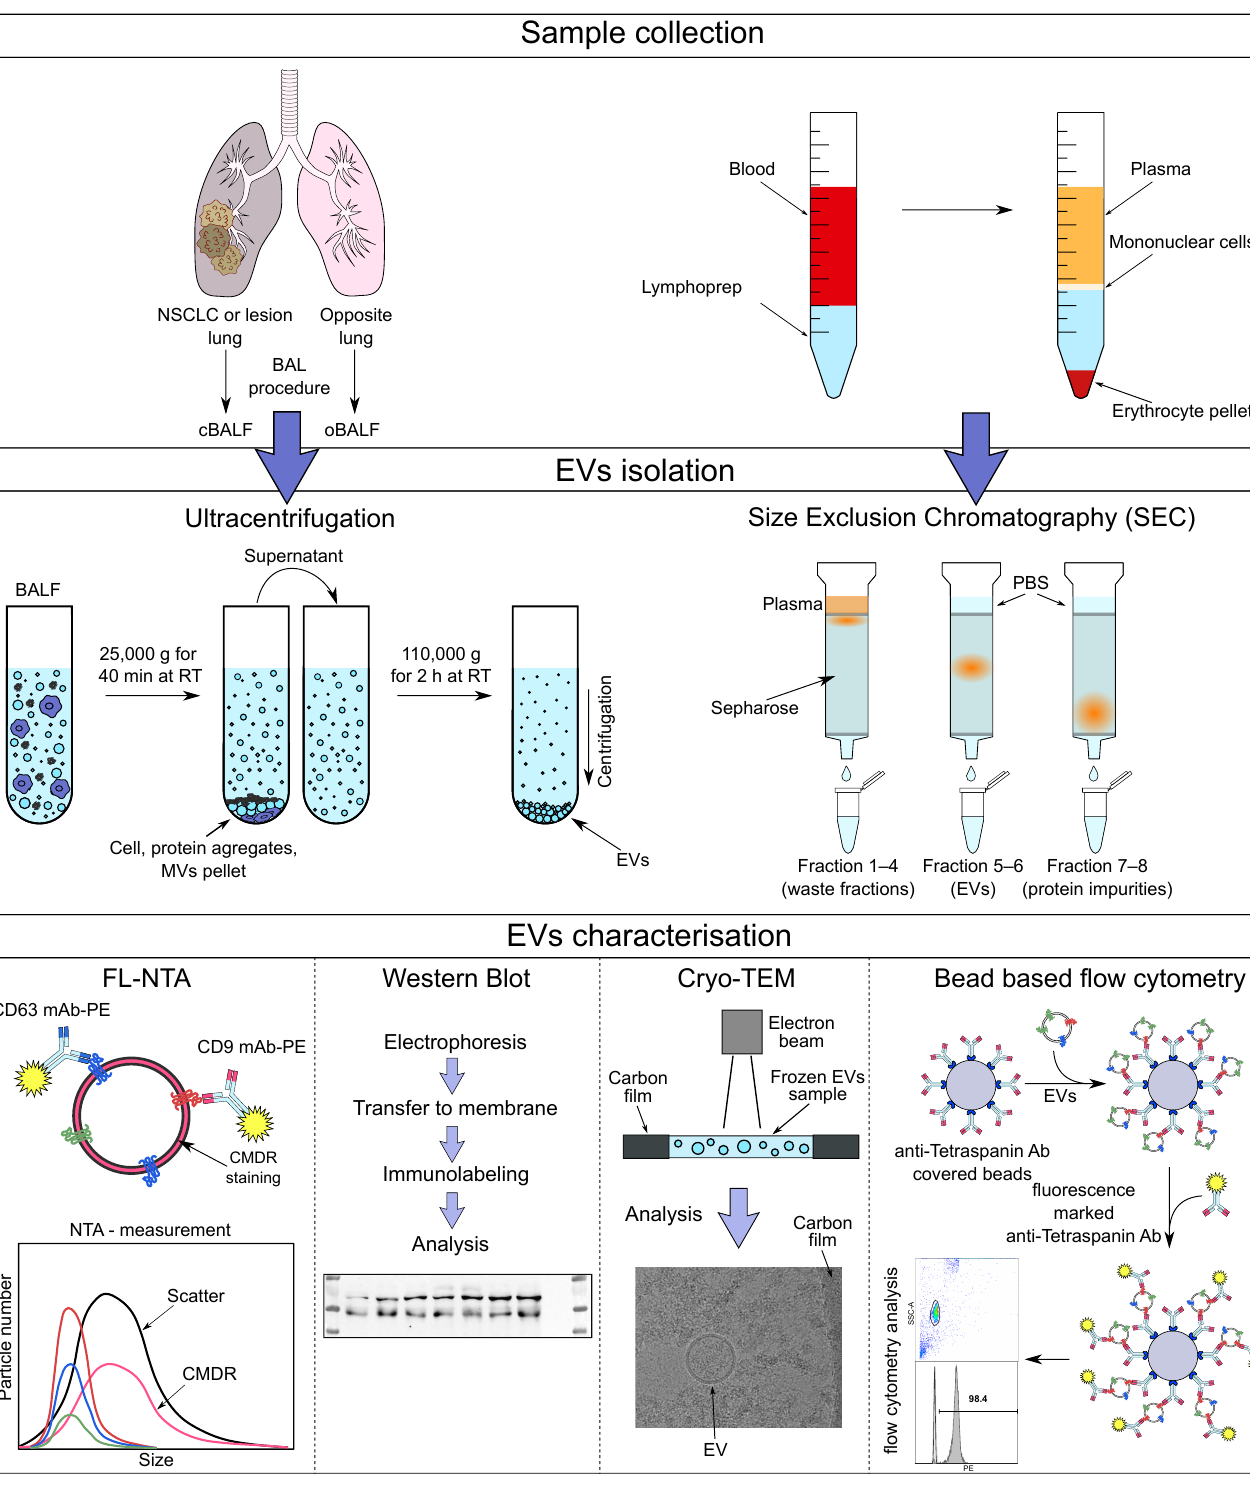
Figure 1. Summary of EV characterization